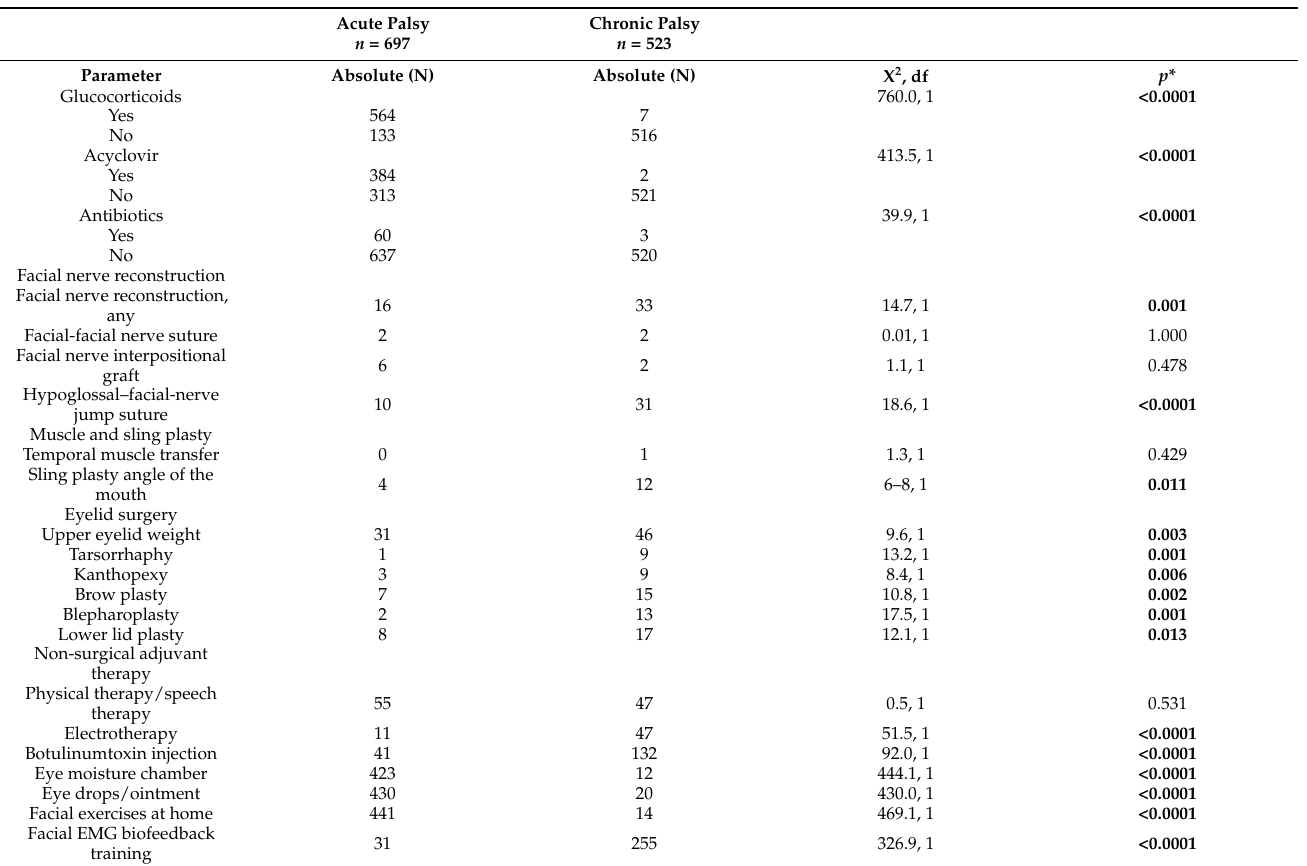
Table 3. Comparison of treatment in the case of acute facial palsy ( ≤ 90 days after onset) versus chronic facial palsy (>90 days after onset). Acute Palsy Chronic Palsy n = 697 n = 523